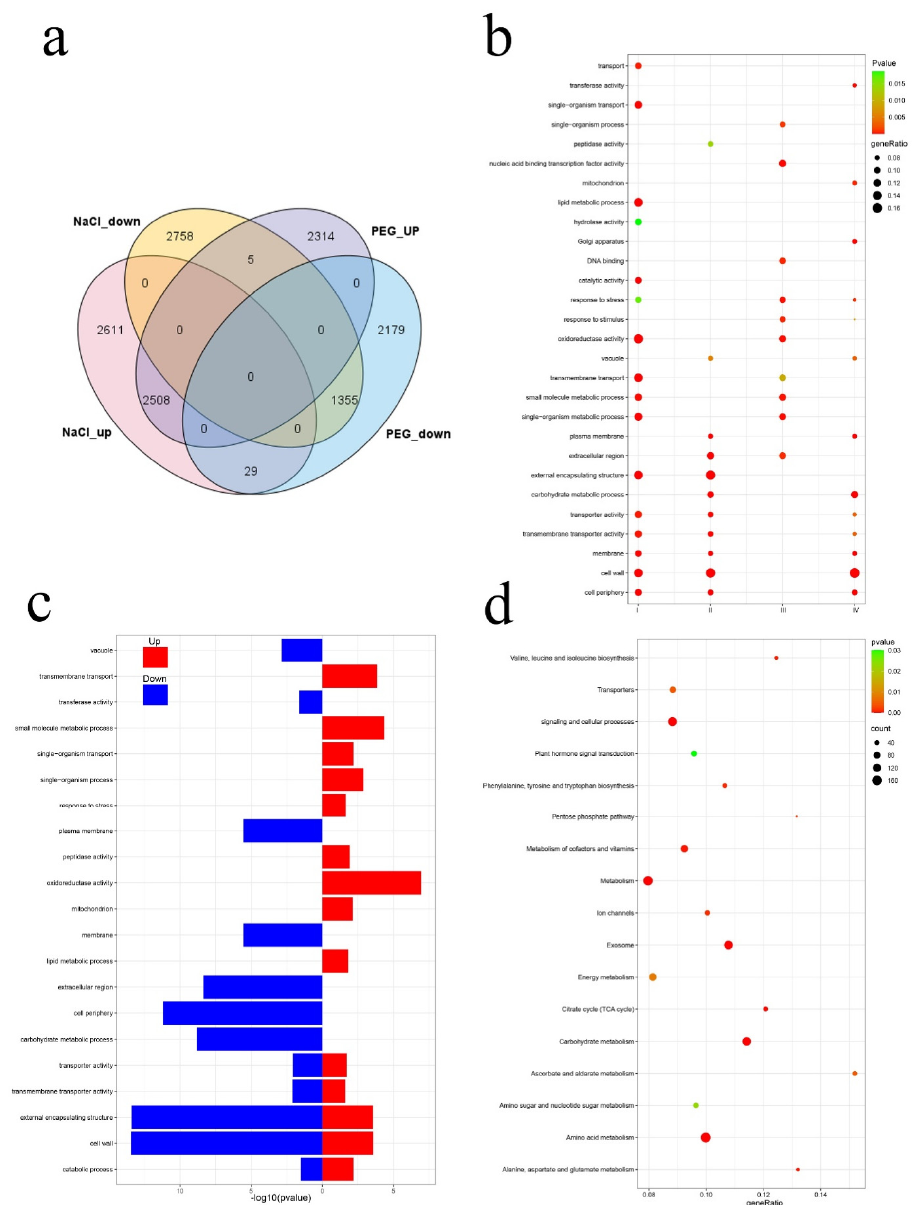
Figure 4. Comparative analysis of the I. lactea var. chinensis transcriptomes. ( a ) Venn diagram of all DEGs. ( b ) GO enrichment of DEGs that were differentially expressed between control and treatments, the size and color of the dots represent the gene ratio and the range of the p -value, respectively. ( c ) GO enrichment of DEGs that had the same expression between NaCl and PEG stress. The degree of GO enrichment is represented by the -log 10 ( p -value). ( d ) Scatterplot of enriched KEGG pathways for DEGs that had the same expression under NaCl and PEG stress. The rich factor is the ratio of the DEG number to the total gene number in a certain pathway. The size and color of the dots represent the gene number and the range of the -log 10 ( q -value),